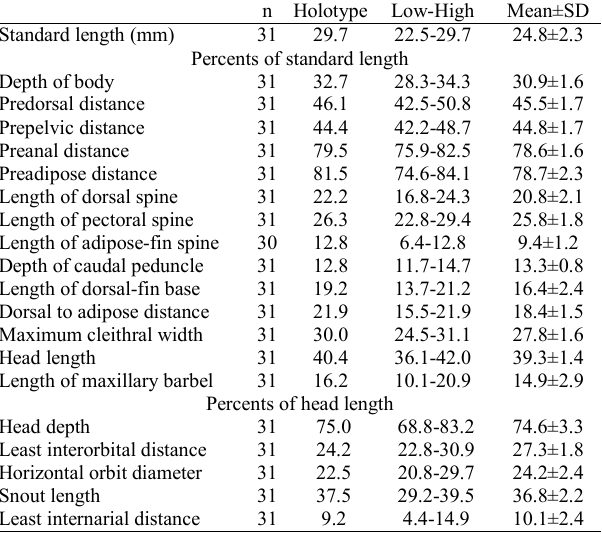
Table 1 . Morphometric data of Corydoras lymnades. n = number of specimens and SD = standard deviation.